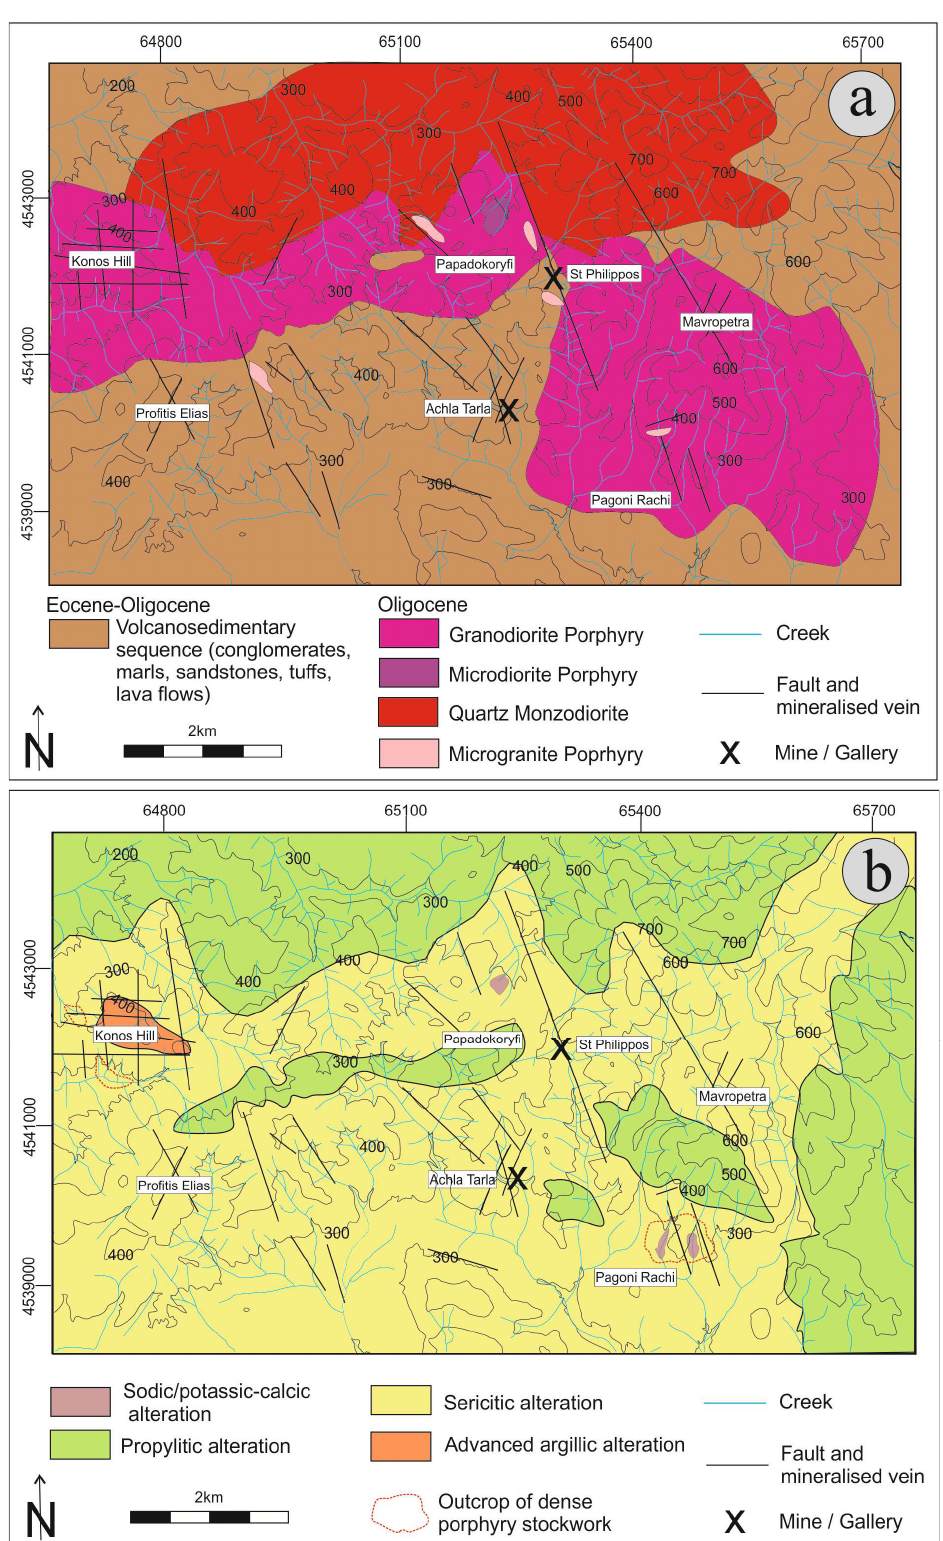
Figure 2. Geological ( a ) and alteration ( b ) map showing the location of the Konos Hill and Pagoni Rachi porphyry-epithermal prospects, among other mineralization occurring in the Sapes-Kirki area.